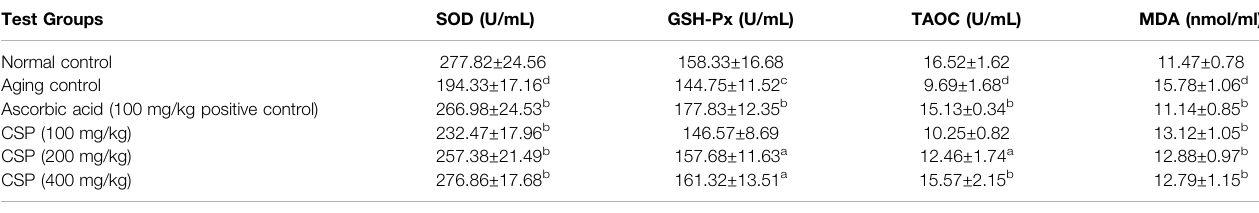
TABLE 3 | Effects of CSP on the activities of SOD, GSH-Px, TAOC and MDA levels in serums in aging mice. Test Groups